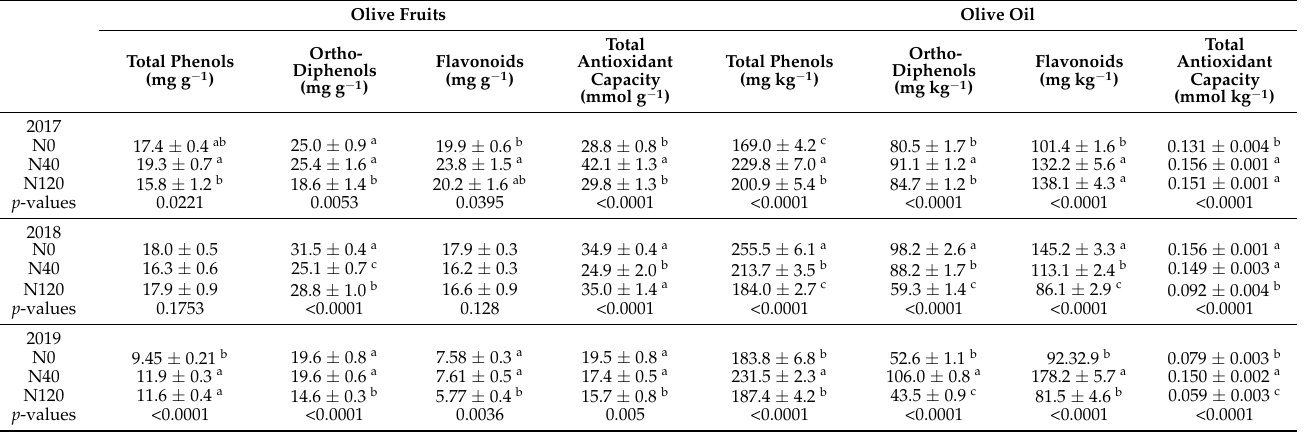
Table 2. Total phenols, ortho-diphenols, flavonoids and total antioxidant capacity on olives and olive oil from olive trees supplied with 0 (N0), 40 (N40) and 120 (N120) kg ha − 1 of N in the harvests of 2017, 2018 and